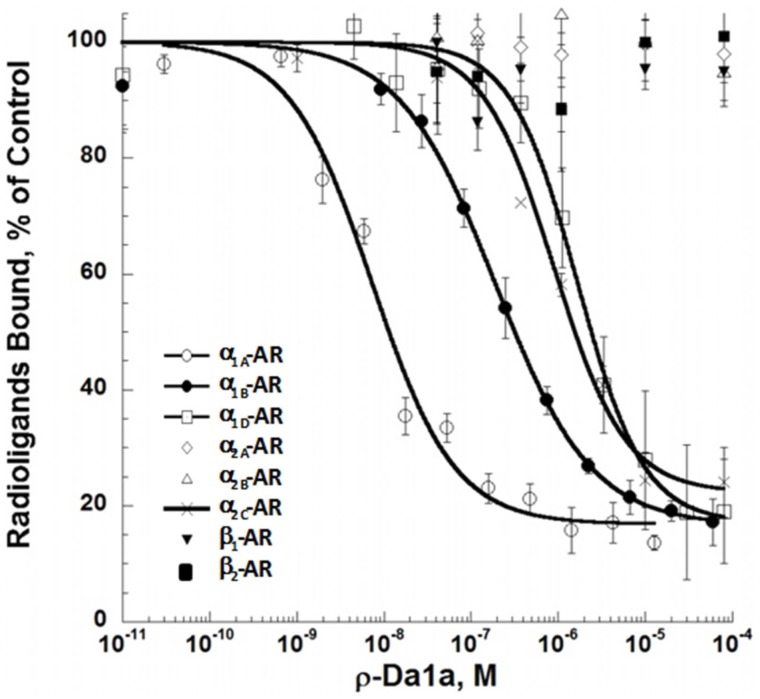
Pharmacological profile of ρ-Da1a binding to various human AR subtypes expressed in eukaryotic cells.Binding inhibition curves for 3H-prazosin (2 nM), 3H-rauwolscine (2 nM) and 3H-CGP-12177 (6 nM) on hα1A- (1 µg, ○), hα1B- (3 µg, •), hα1D- (29 µg, □), hα2A- (140 µg, ◊), hα2B- (100 µg, Δ), hα2C- (3 µg, x), β1- (3 µg,▾) and β2-AR (1.5 µg, ▪) with recombinant ρ-Da1a. n = 4.